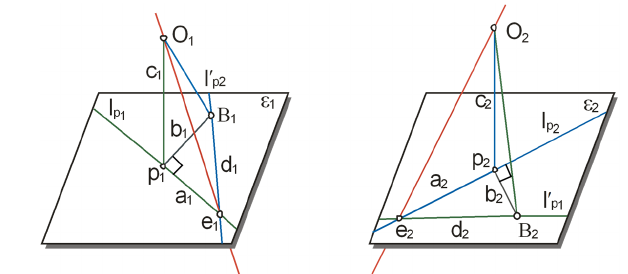
Figure 1. Epipolar planes Π 1 , Π 2 of the optical axes of the two cameras define a dihedral angle β . Plane Π 1 intersects the two image planes ε 1 , ε 2 at epipolar lines l p1 and l p1 ′ , and Π 2 intersects them at lines l p2 ′ and l p2 , respecti- vely. These lines correspond to the epipolar lines of the two pri- ncipal points p 1 , p 2 and can be estimated by joining principal points p 1 , p 2 with the epipoles e 1 , e 2 :